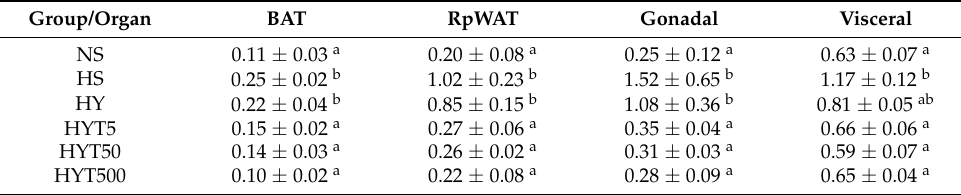
Table 1. Percentage of fat in visceral, BAT, gonadal, and RpWAT of female offspring on PND 21. Group/Organ BAT RpWAT Gonadal